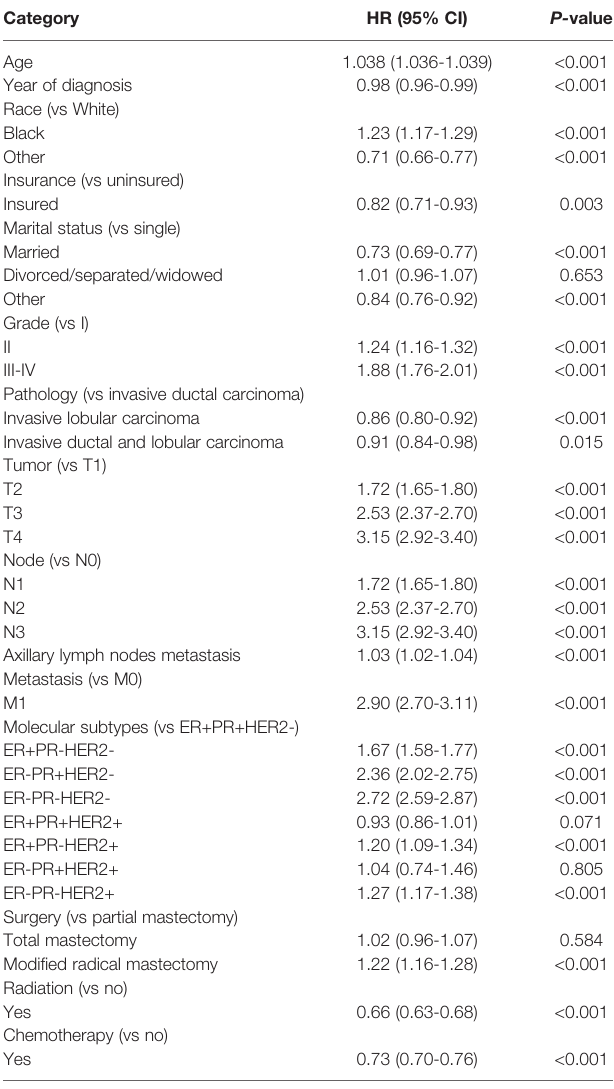
TABLE 2 | Overall survival by multivariate Cox proportional